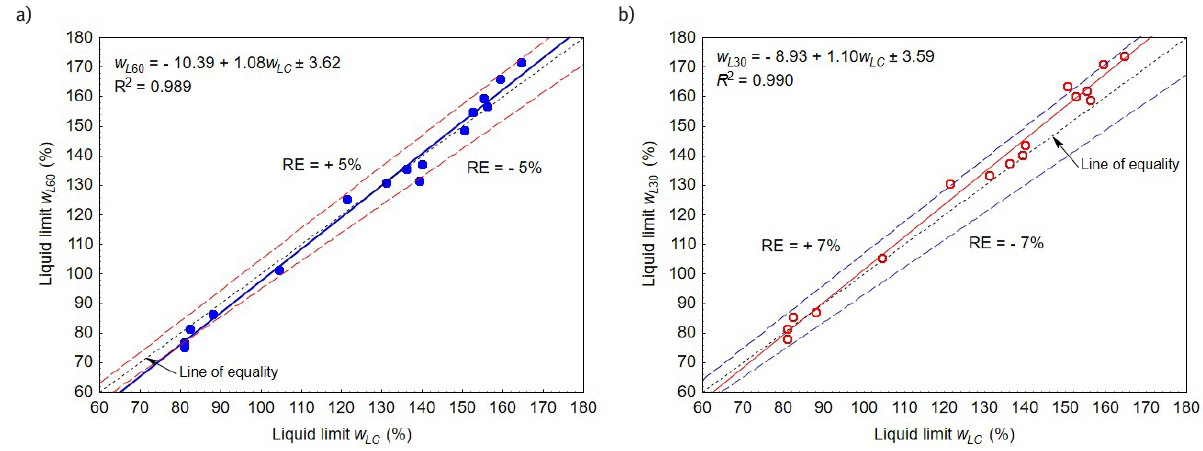
= f( w ), b) w = f( w ). L 60 LC L 30 LC